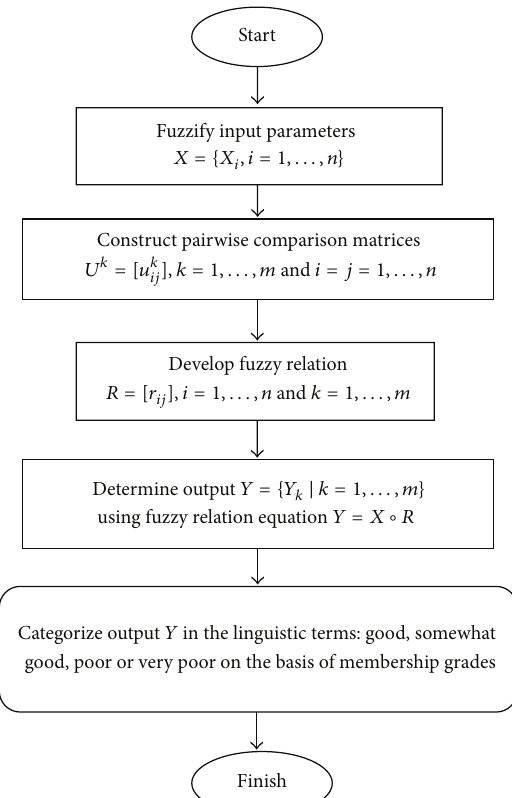
Figure 1: Flow chart.